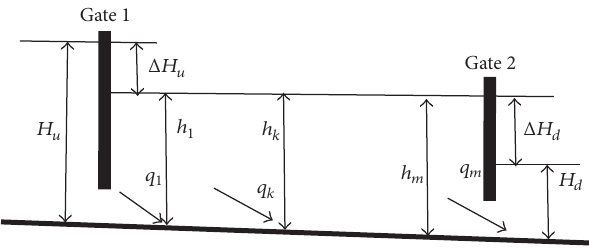
Figure 1: Structure of one single-pool canal.